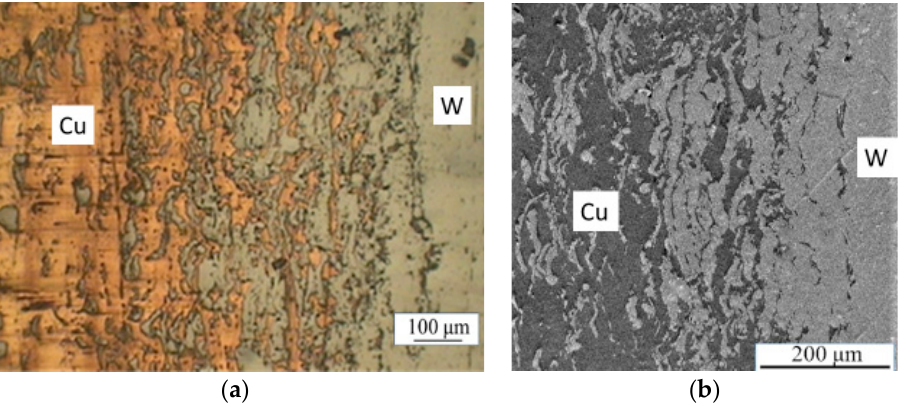
Figure 3. The stratified structure of the interlayer is shown at different magnifications in LM ( a ) and SEM ( b ) micrographs.